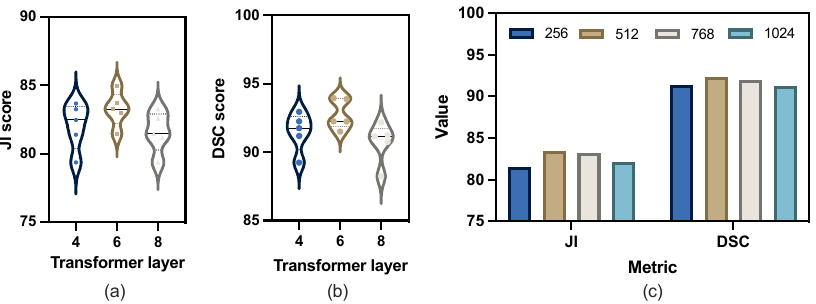
Figure 6. Ablation experiments with various transformer layers ( a , b ) and embedding dimensions ( c ).